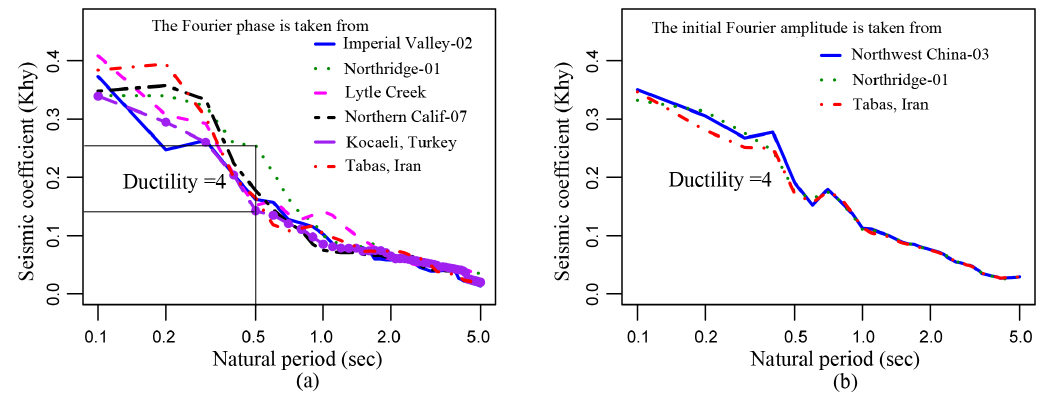
Figure 1. YSC demand spectra calculated from DRSCEMs simulated by ( a ) Same initial Fourier amplitude and different phases and ( b ) Same phase and different initial Fourier